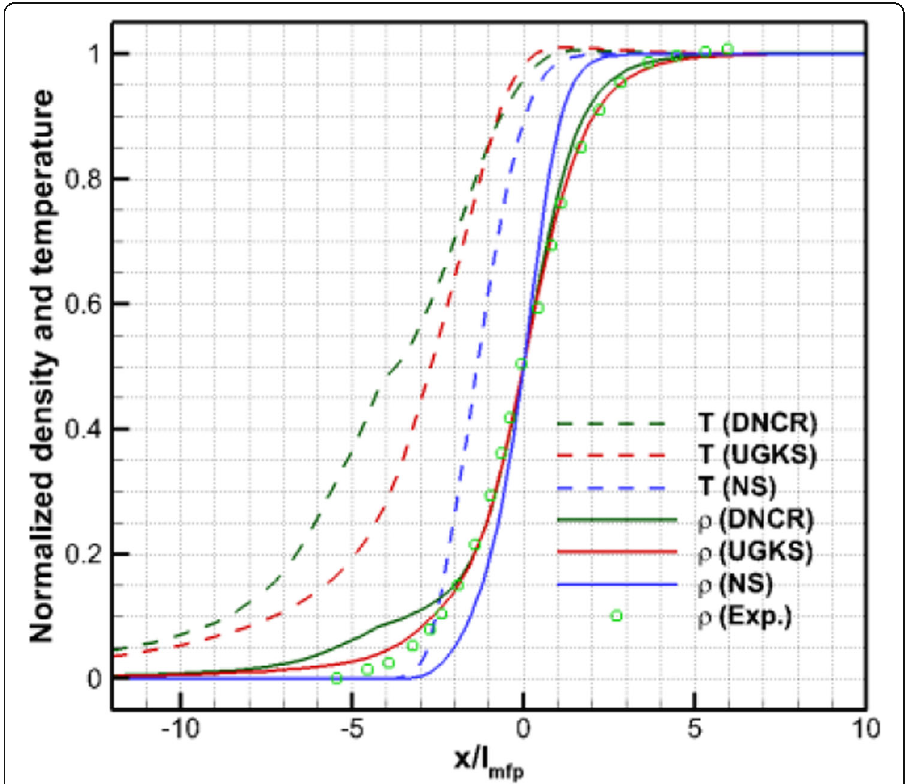
Fig. 4 Comparisons of flow variables in shock structure in a monatomic gas with experimental data using the NS, UGKS and DNCR at Mach